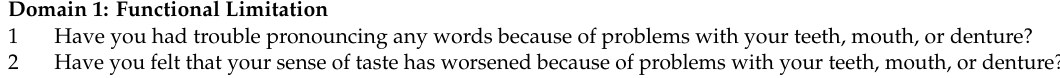
Table 1. OHIP-14 questionnaire divided per